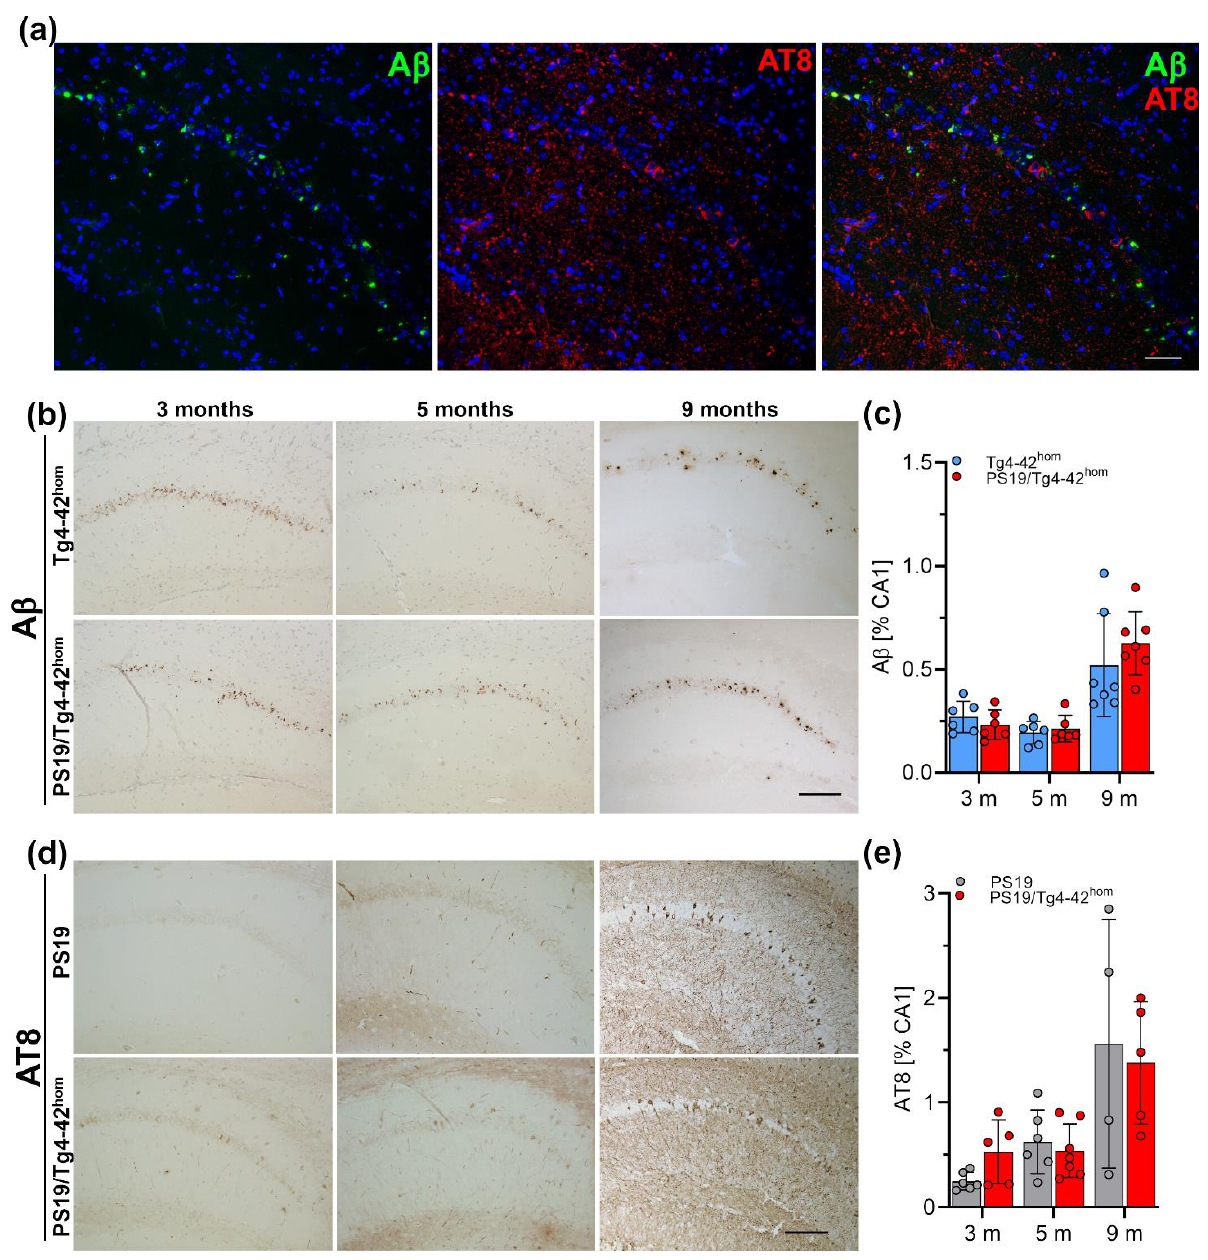
Figure 5. Phosphorylated tau and Aβ 4–42 immunoreactivity. ( a ) Fluorescent staining of Aβ 4–42 (green) and phosphorylated tau protein (AT8—red) in the CA1 pyramidal layer from a 3-month-old PS19/Tg4–42 hom mouse did not reveal a major co- localization. Representative Aβ ( b ) and AT8 ( d ) staining in CA1 of PS19, Tg4–42 hom and PS19/Tg4–42 hom mice. Immunohisto- chemical analysis (n = 5–7 per time point, 3 sections per animal) showed no difference in A β immunoreactivity between Tg4–42